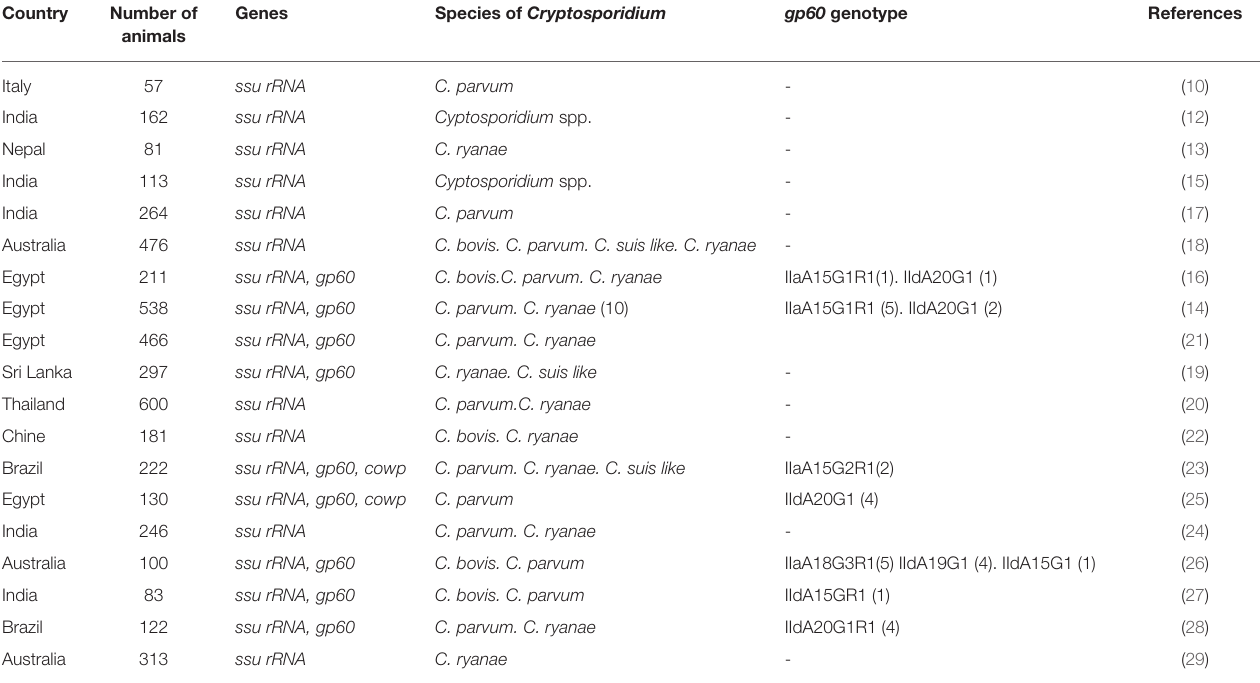
TABLE 3 | Species and subtypes of Cryptosporidium in buffaloes worldwide. Country Number of